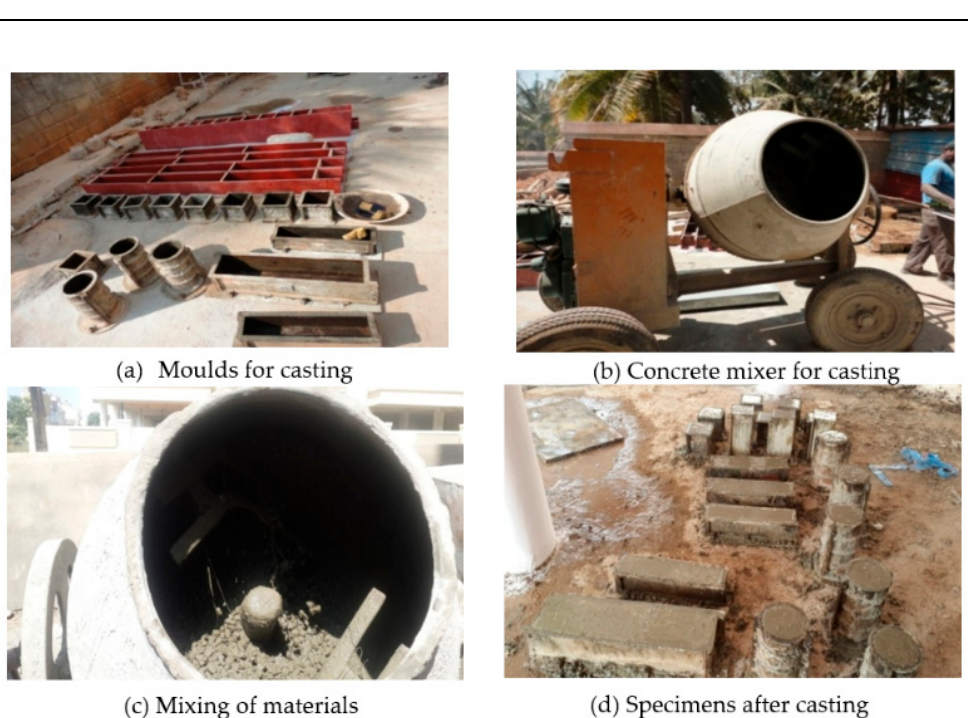
Figure 2. Details of casting of concrete specimens for testing.